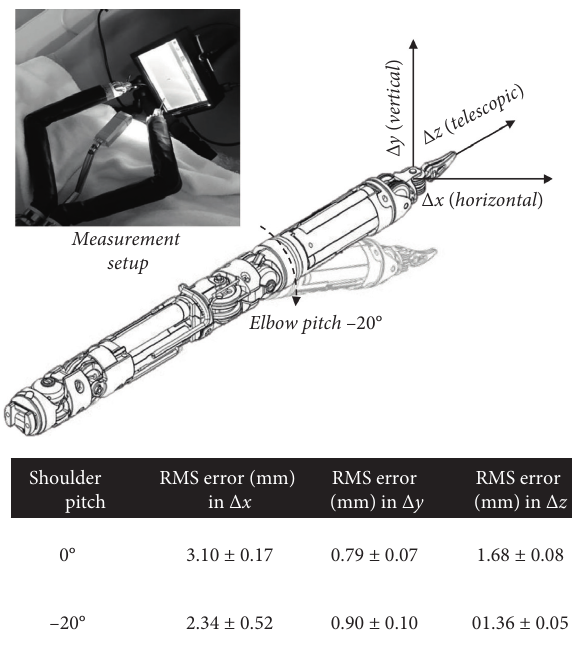
Figure 7: Average RMS error in three orthogonal directions with robotic arm elbow pitch at 0 ° and − 20 °